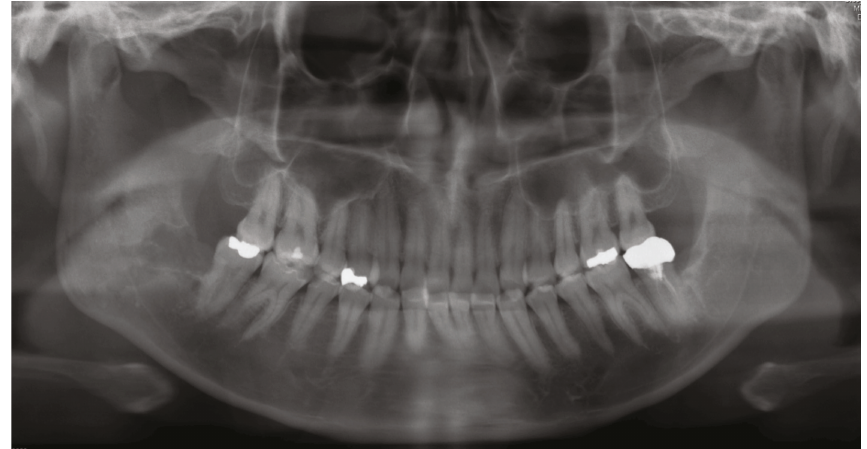
Figure 2: A panoramic radiograph obtained during the initial visit. The radiograph shows radiolucency from the extraction socket to the right mandibular